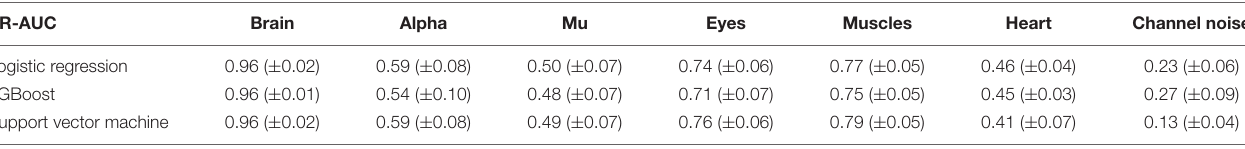
TABLE 5 | Average F1-scores and their standard deviations. PR-AUC Brain Alpha Mu Eyes Muscles Heart Channel noise Logistic